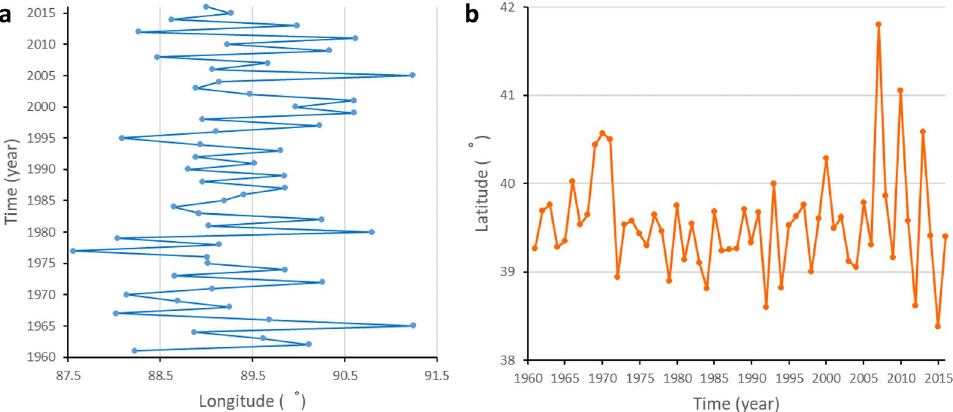
Figure 5. Longitudinal and latitudinal variations of the spatial center of the arid region’s precipitation ( a ) longitudinal variations and ( b ) latitudinal variations.